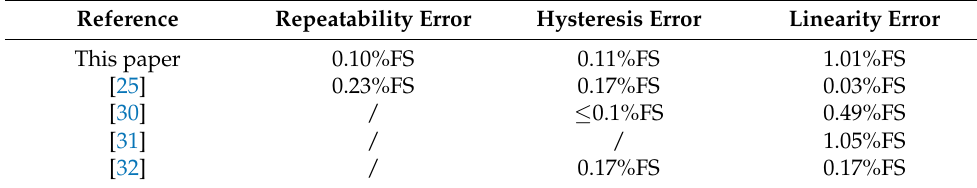
Table 3. Static performance index comparison.